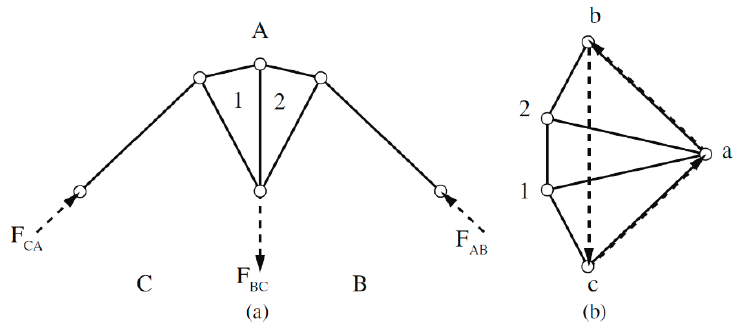
Figure 1. Example of reciprocal diagrams: ( a ) form diagram and ( b ) force diagram [6].